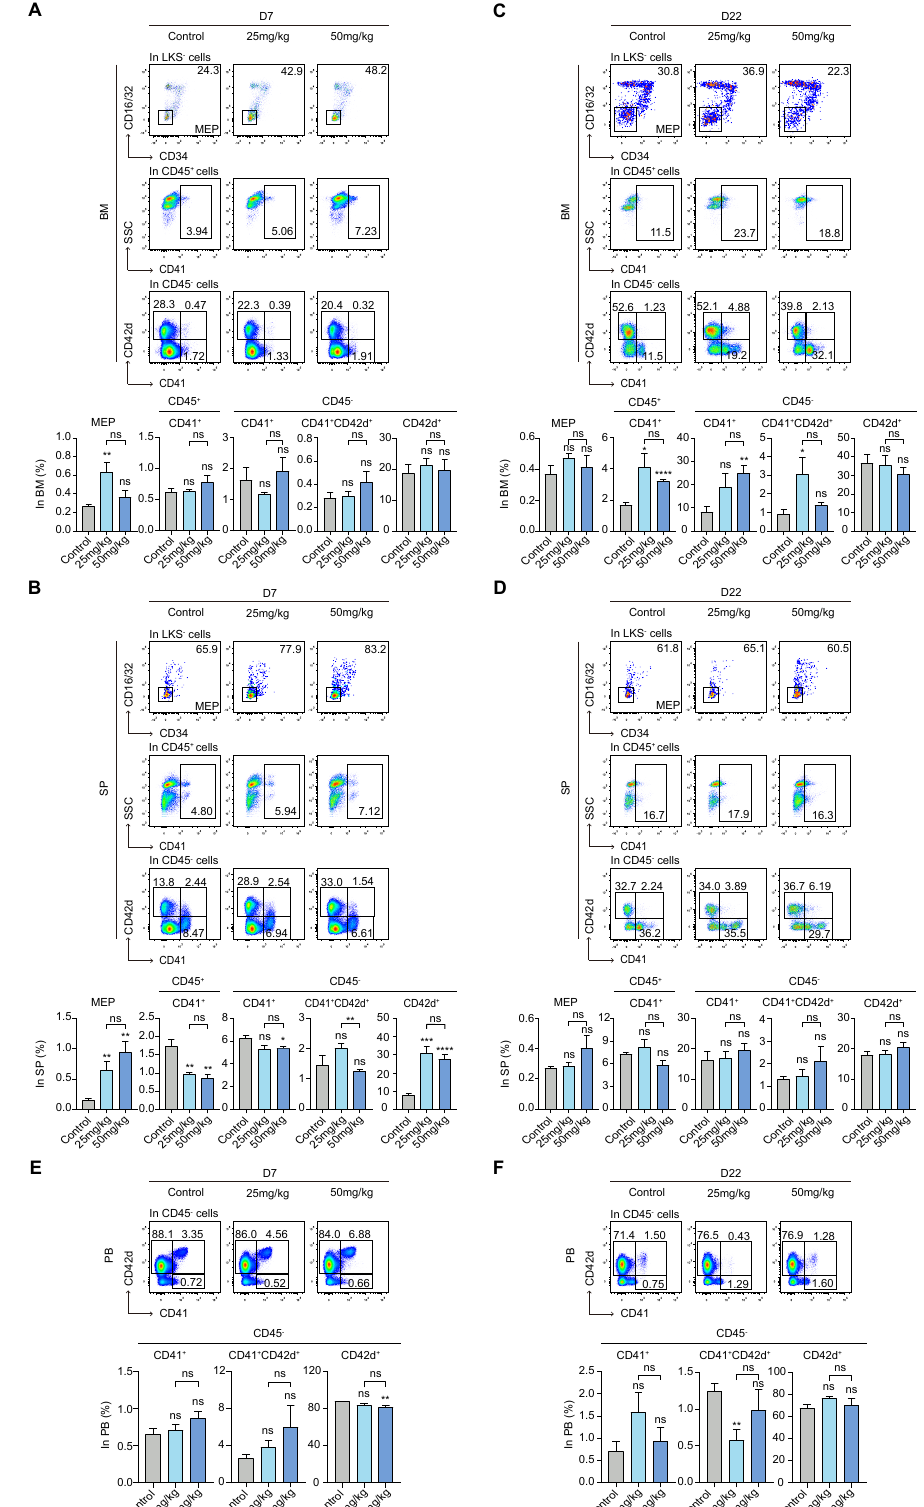
Figure 4. Effect of S63845 treatment on megakaryocytic differentiation in CB6F1 mice. ( A ) Represen- tative FACS profiles and percentages of MEP, CD45 + CD41 + , CD45 − CD41 + , CD45 − CD41 + CD42d +